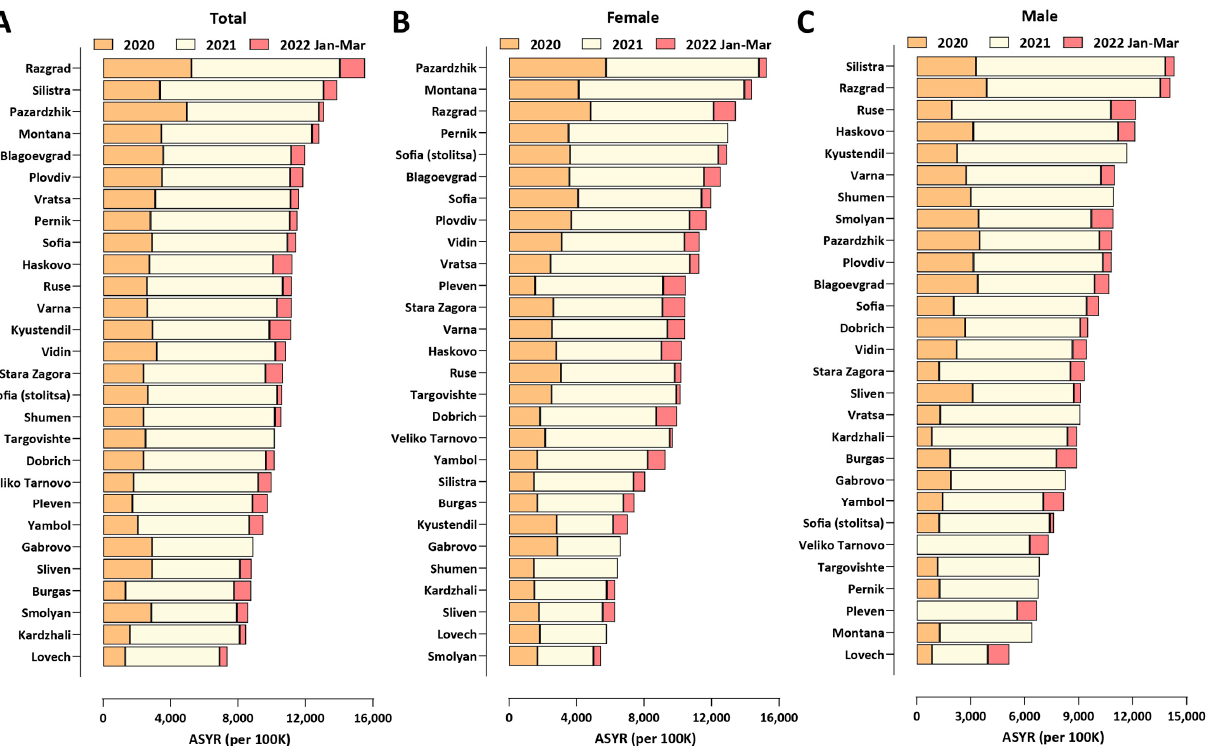
Figure 5. Regional excess mortality patterns in Bulgaria during the COVID-19 pandemic (up to the end of March 2022). ( A ) Total, standardized ASYR values; ( B ) Female, standardized ASYR values; ( C ) Male, standardized ASYR values.